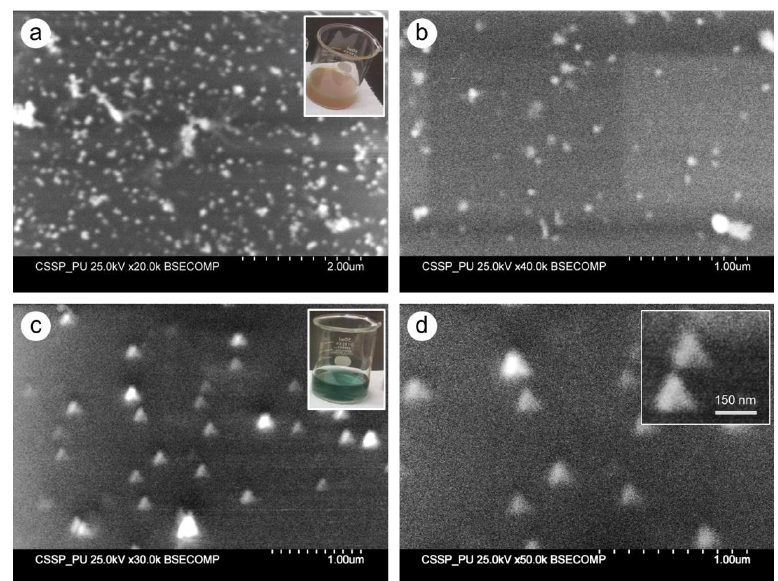
Figure 3. SEM images of Sample 1 at lower ( a ) and higher ( b ) magnification showing the spherical morphology of the particles. The triangle-shaped silver particles are represented in ( c ) and ( d ) at different magnifications. The inset showed the color of sample S1 and sample S2 solution the beaker. Nanomaterials 2016 , 6 , 74